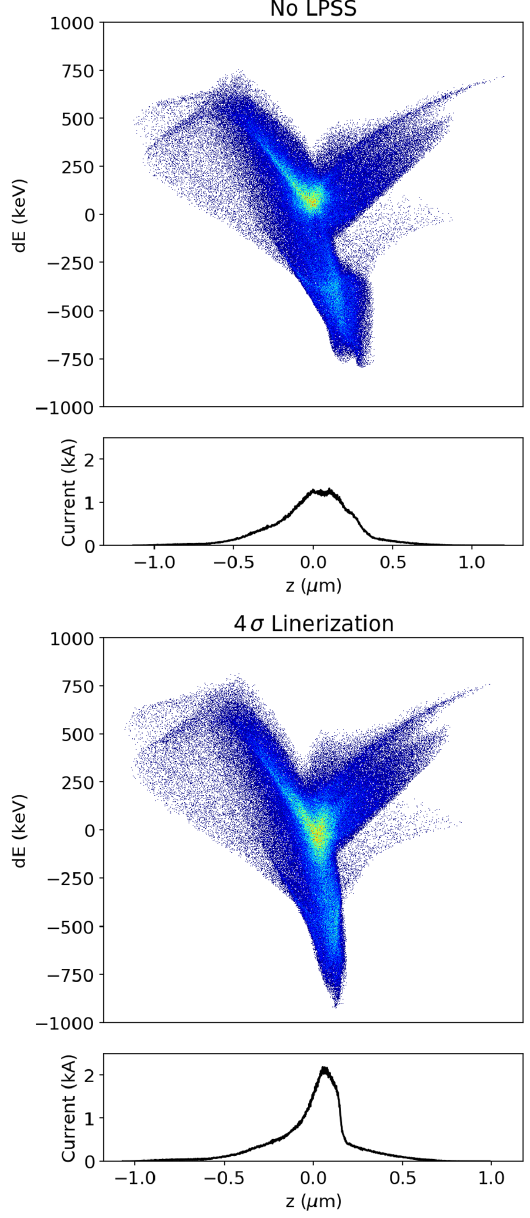
FIG. 10. Numerical simulation of the longitudinal phase space and current profile of the ARES working point WP4 shown in Table III, 1.75 m downstream of the chicane exit ( z ¼ 30 . 5 m). Top: bunch compression without applying the LPSS optimiza- tion, i.e., no structure. Bottom: bunch compression after applying a 4 σ linearization with an optimized LPSS